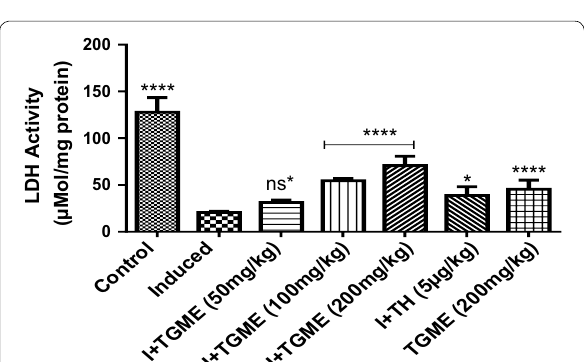
Fig. 18 Effect of aqueous methanolic leaf extract of Triclisia gilletii on LDH activities in the kidney of animals administered ethane-1,2-diol. Data are expressed as mean SEM of 6 rats ( n 6); ns* > 0.05, ± = * p < 0.05, and **** p < 0.0001; *denotes that data were compared SEM of 6 rats ( n 6); ± =